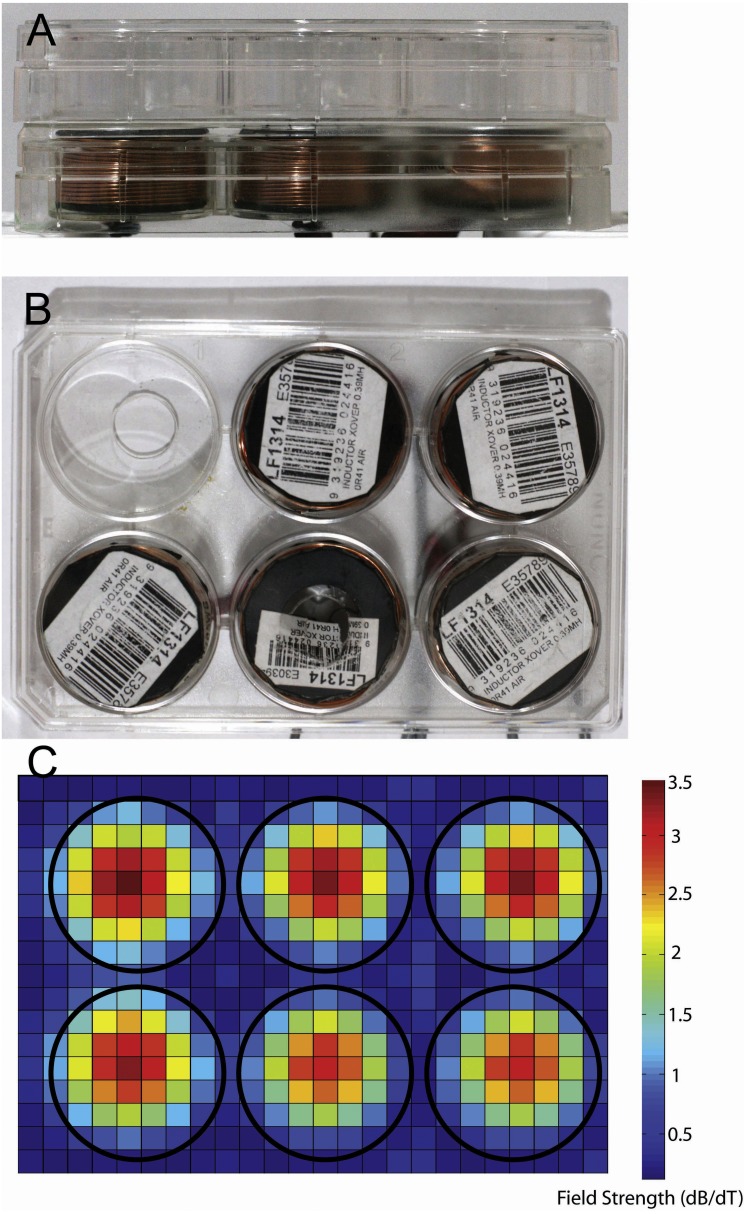
Photographs showing equipment used for magnetic stimulation of cells.Stimulation equipment. (A, B) Photographs of the in vitro stimulation coils used in this study. Views are from the side (A) and top (B). The coils were situated at a distance of 2.8 mm from the bottom of the culture well because of the thickness of the coverplate and base of the culture dish. (C) Heatmap showing the measured change in magnetic field for a single pulse (dB/dT) when 6 coils are placed in a 6-well plate arrangement. Note the lack of overlap of magnetic field between the coils/wells of the plates.